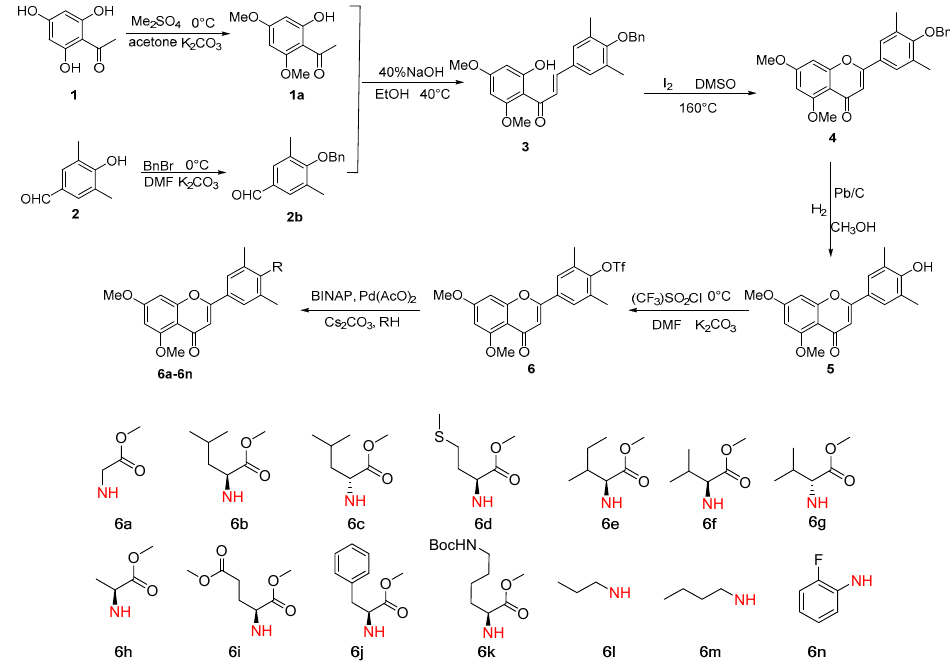
Scheme 1. Synthesis of flavone derivatives.